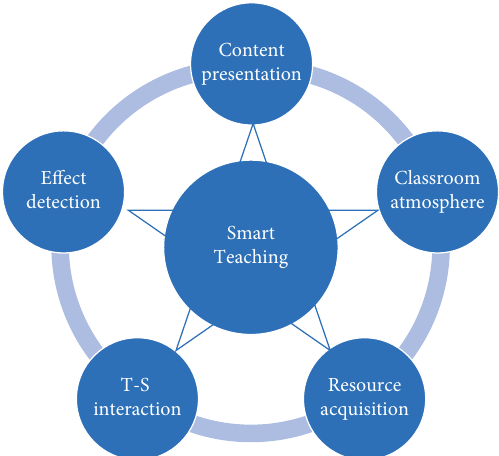
Figure 6: Smart teaching framework for English